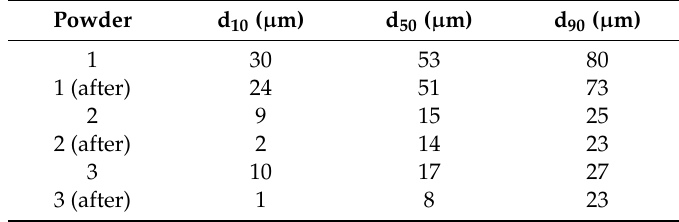
Table 3. Particle size distributions of LC feedstocks before and after ultrasonic